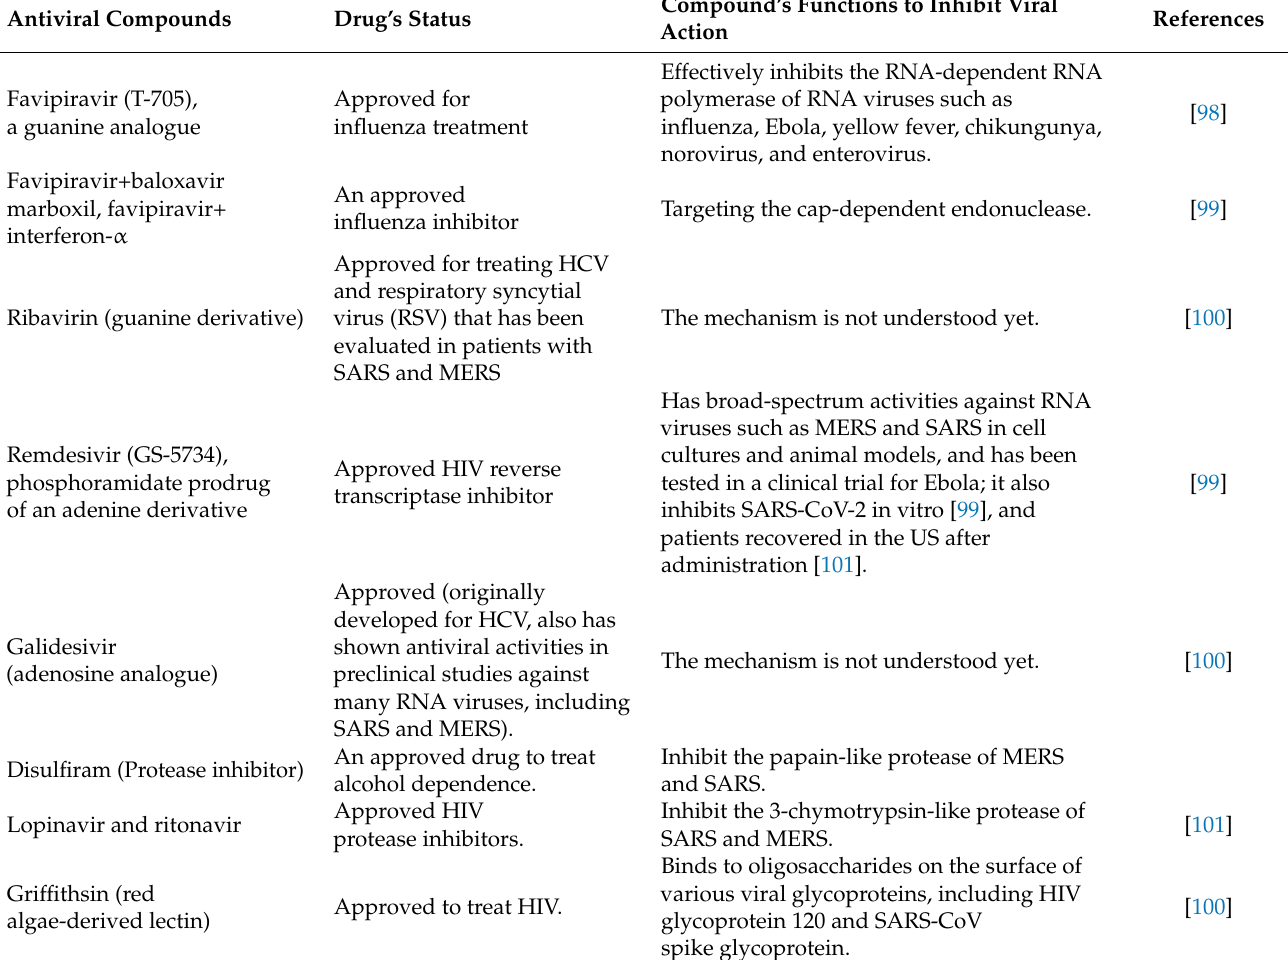
Table 5. Potential therapeutic compounds and drugs for SARS-CoV-2 treatment (in trials). Compound’s Functions to Inhibit Viral Antiviral Compounds Drug’s Status